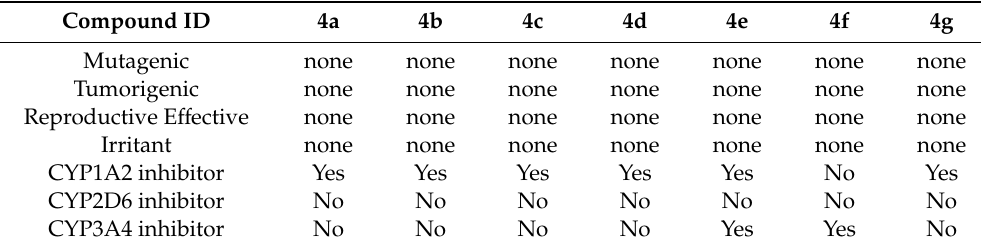
Table 6. The predicted toxic e ff ects of all the synthesized compounds.